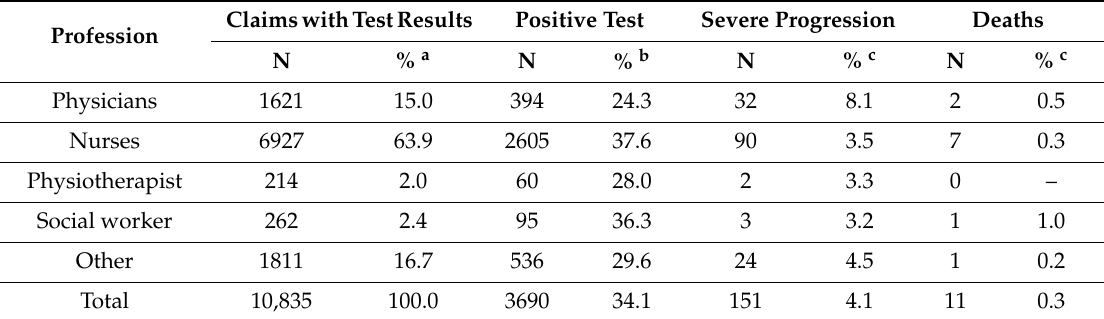
Table 4. COVID-19 cases reported to the accident insurance provider BGW broken down by activities /